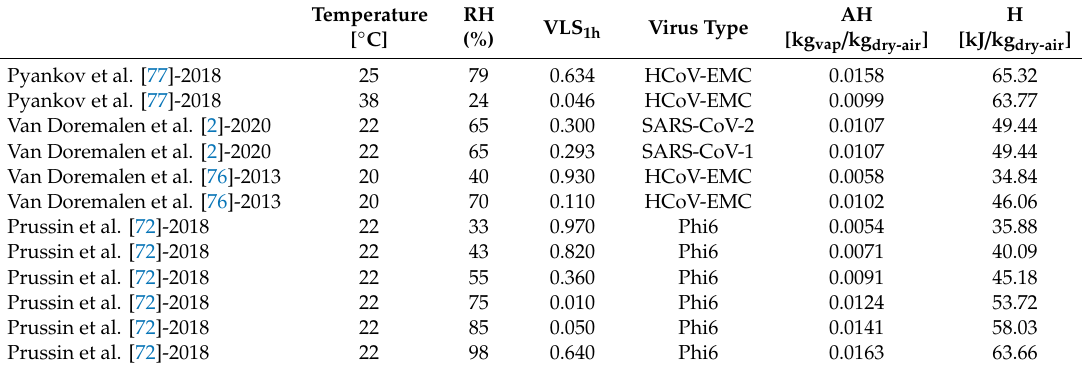
Table 1. Virus survival obtained from literature experimental data and related